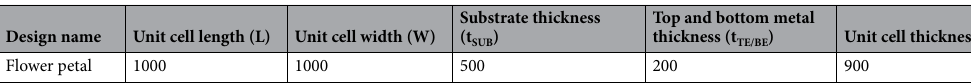
Table 2. The geometric parameters and dimensions of proposed antenna (nm).